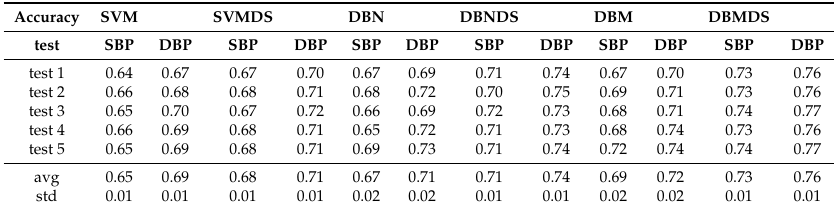
Table 2. Performance comparison of SBP (systolic blood pressure) and DBP (diastolic blood pressure) with respect to classification rate among SVM (support vector machine) [28], SVM with DS (Dempster–Shafer) fusion (SVMDS), DBN (deep belief network) [10], DBN with DS(DBNDS), DBM (deep Boltzmann machine) [12], and the proposed DBM-based DS fusion (DBMDS) scheme.